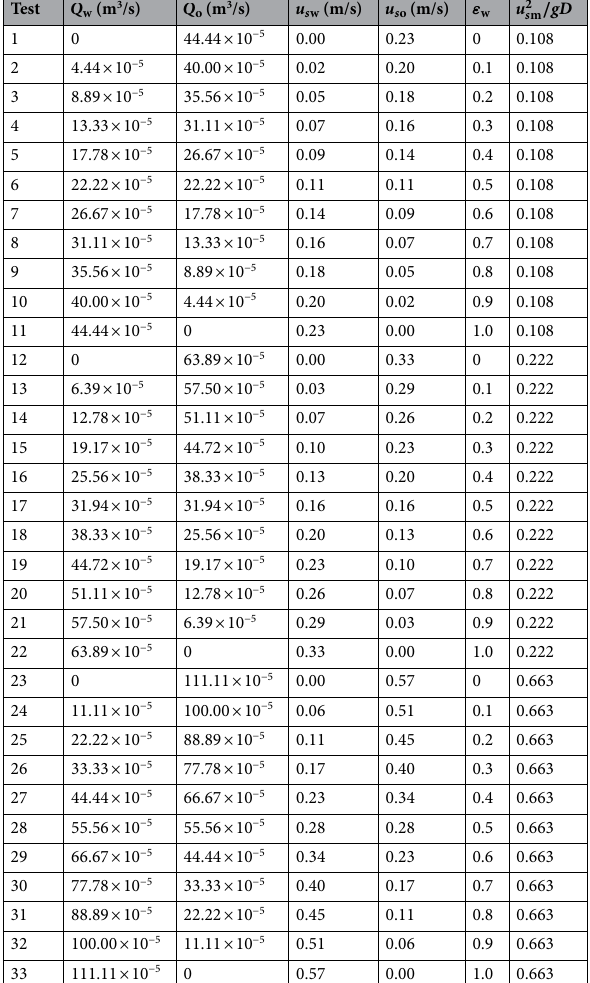
Table 2. Data structure for the oil–water pipe flow experiments ( Eo = 90.53 , µ o /µ w = 32 , ρ o /ρ w = 0.84